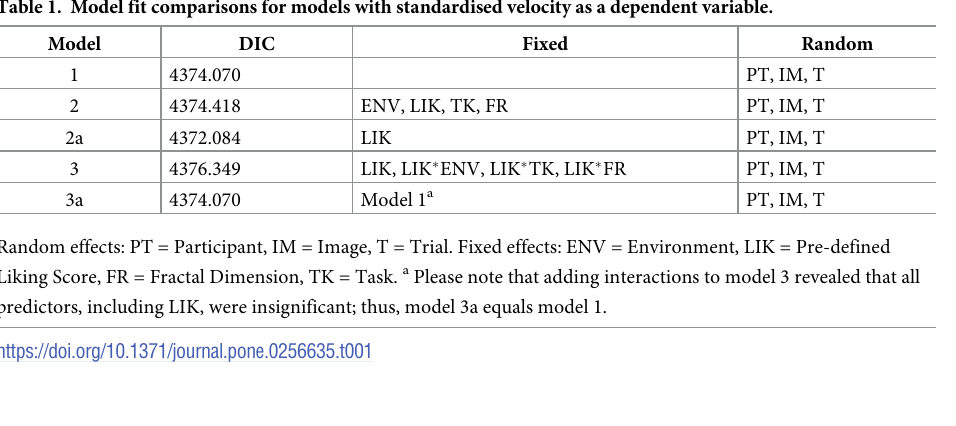
nature (p < 0.001) and urban conditions (p < 0.001), but nature and urban conditions did not